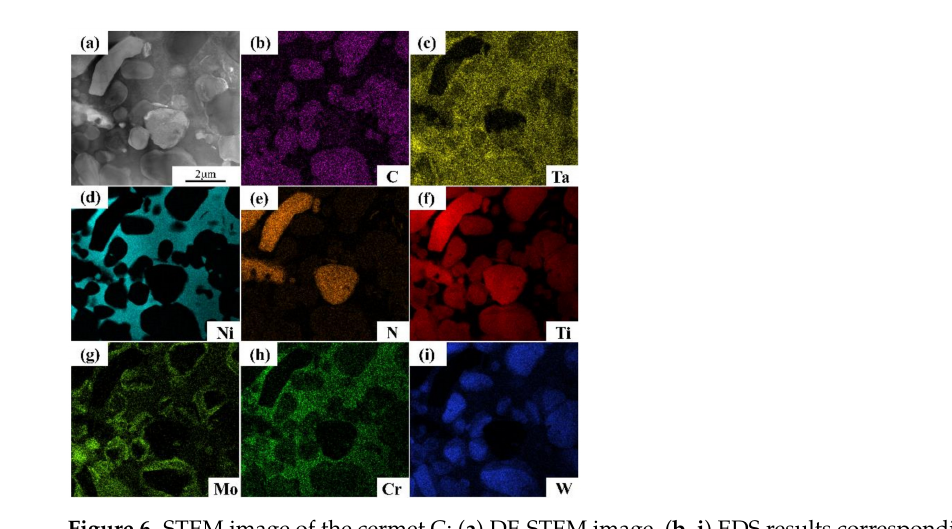
Figure 6. STEM image of the cermet C: ( a ) DF-STEM image, ( b – i ) EDS results corresponding to ( a ).